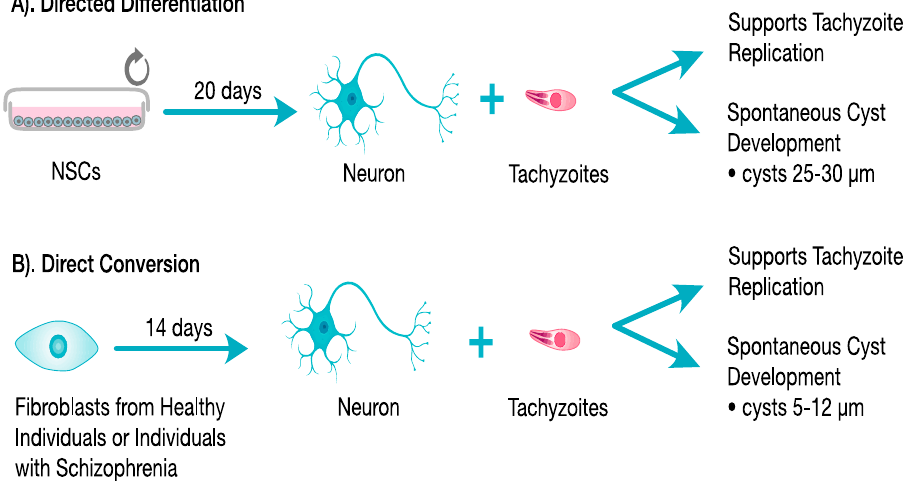
Figure 3. Studies of T. gondii using reprogrammed human neurons. Using a directed differentiation method ( A ), NSCs were used to derived human neurons in 20 days and then infected with T. gondii tachyzoites. Using a Direct Conversion method ( B ), starting from fibroblasts derived either from healthy controls or individuals with Schizophrenia, induced human neurons (iNs) were generated in 14 days and then infected with T. gondii tachyzoites. In both human neuronal models, neurons supported tachyzoite replication and bradyzoite replications, which lead to spontaneous cyst development. In fibroblasts for example, typically less than 10% tachyzoite vacuoles spontaneously convert to cysts.